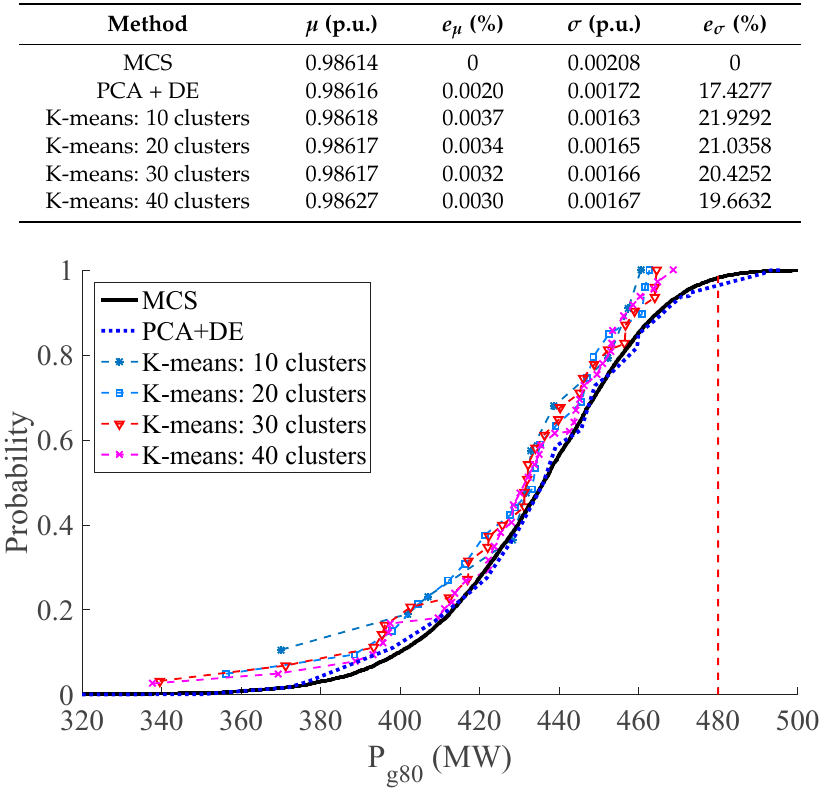
Figure 4. CDFs of power output of generator at bus 80.